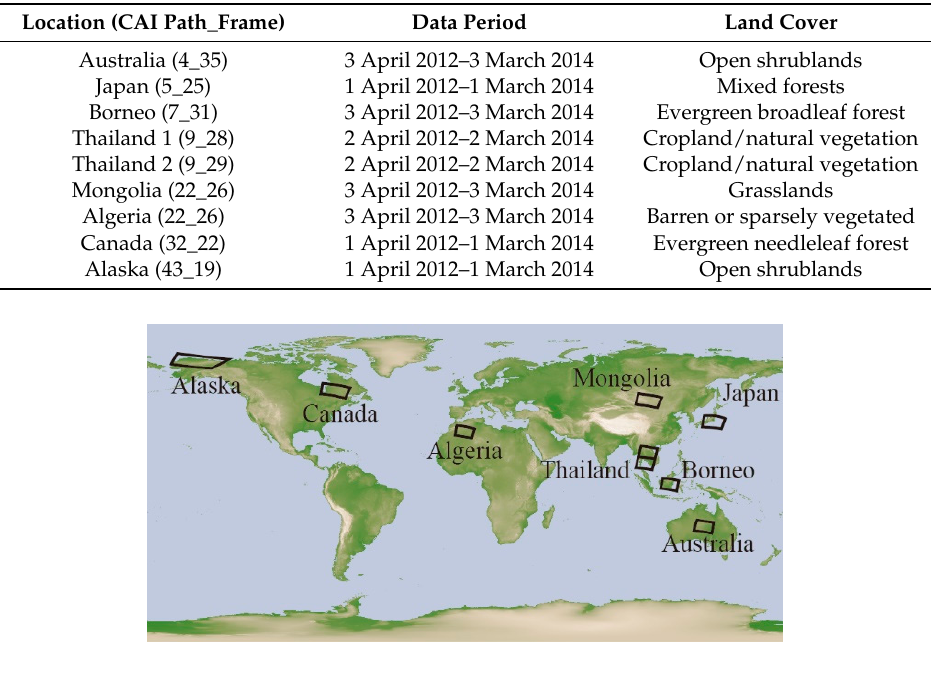
Figure 1. Study areas. Black rectangles indicate the locations of CAI frames.